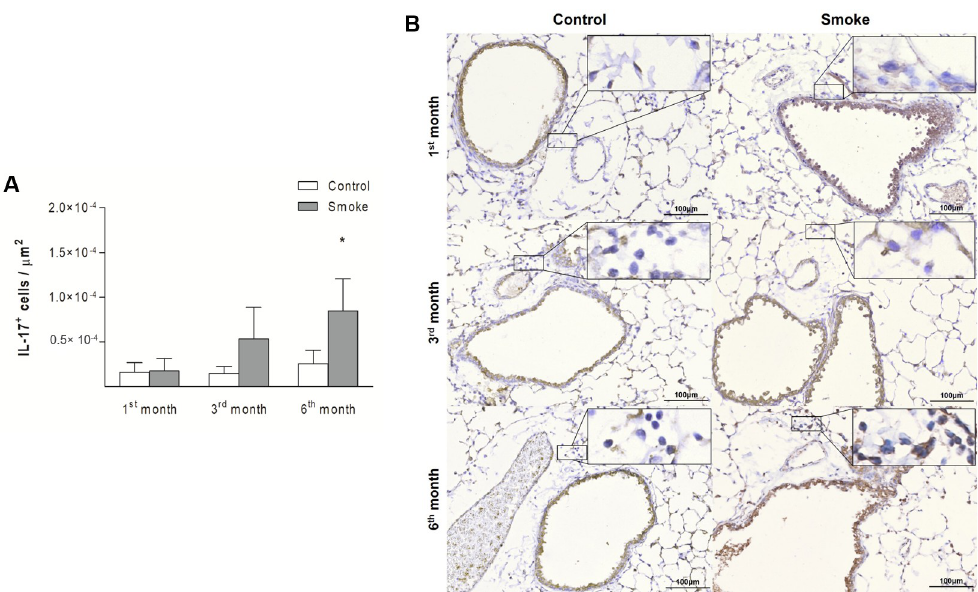
Fig 7. IL-17 + cells in peribronchovascular areas. The numbers of IL-17 + cells in peribronchovascular areas obtained for the Control groups after 1 (n = 10), 3 (n = 6), and 6 (n = 5) months and Smoke groups after 1 (n = 9), 3 (n = 6), and 6 (n = 9) months are presented as the means ± SDs. (A) Significant difference was found after 6 ( � P = 0.0048, t-test) months. (B) Representative photomicrographs of IL-17 + cells in peribronchovascular areas are shown at 200 × magnification, and images at 1000 × magnification are shown in each